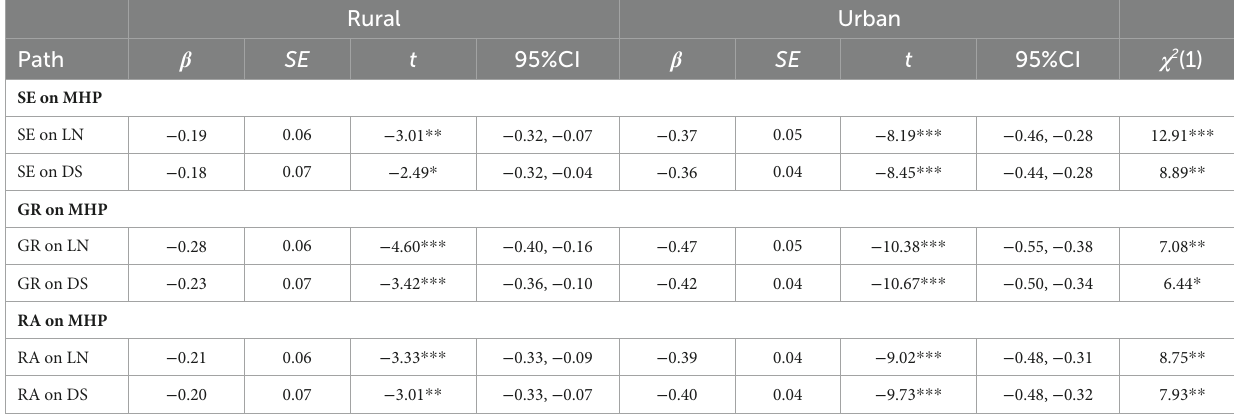
TABLE 6 Multigroup invariance of group orientation on mental health problems across rural–urban